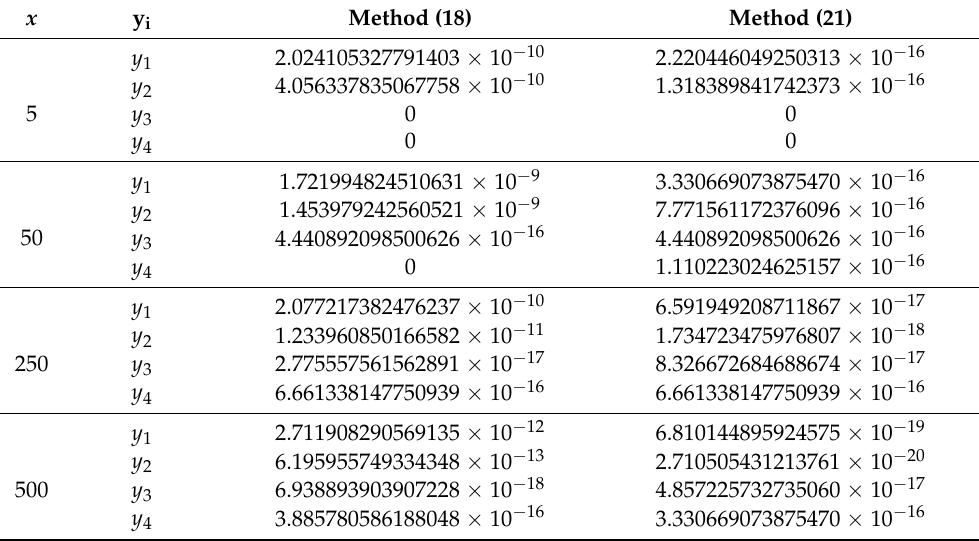
Table 5. Absolute errors of numerical integration of example 5.